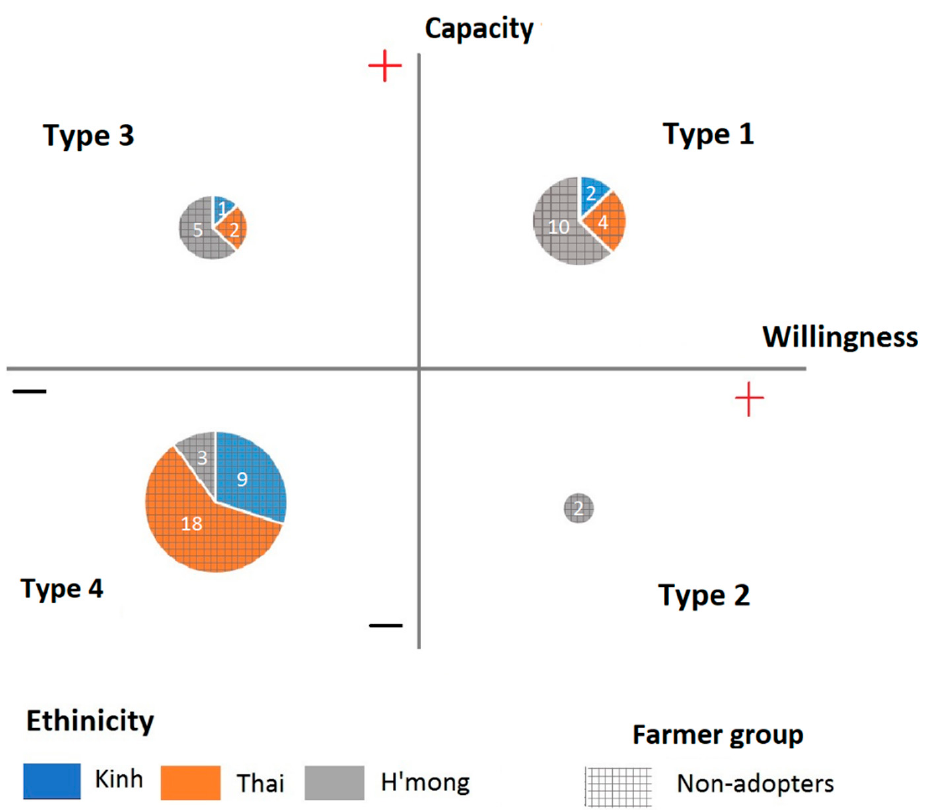
Figure 4. Non-adopter farmers’ capacity and willingness to adopt agroforestry ( n = 56).